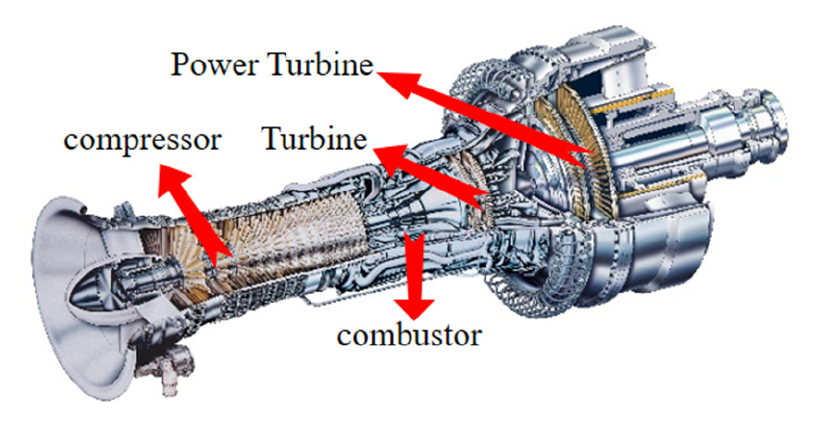
Figure 3. Schematic of the PGT25+ gas turbine. ing locations of the gas turbine are shown in Figure 4, where selected as the dependent parameters and